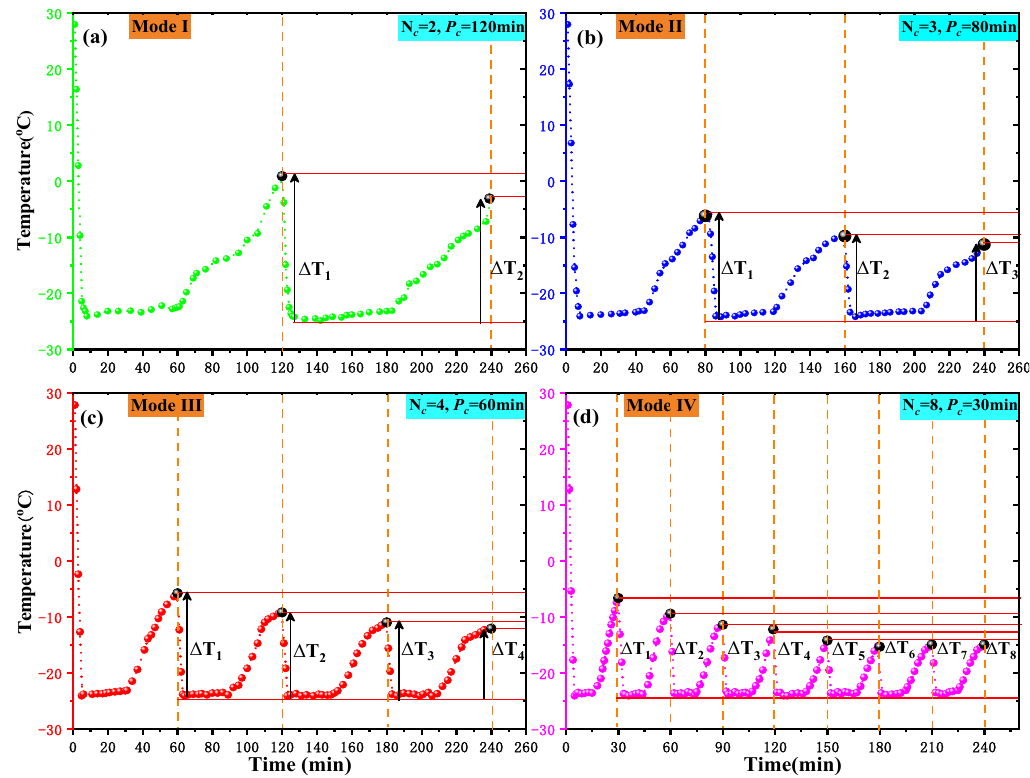
Figure 9. Variation in the effective porosity φ e of the three coal cores. ( a ) Model I. ( b ) Model II. ( c ) Model III. ( d ) Model IV.